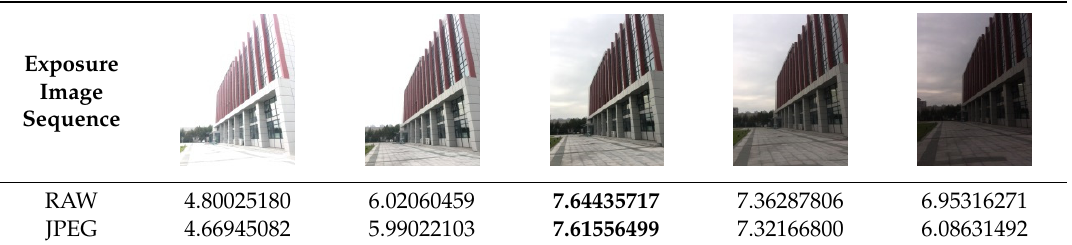
Table 1. The information entropy of the image sequence.